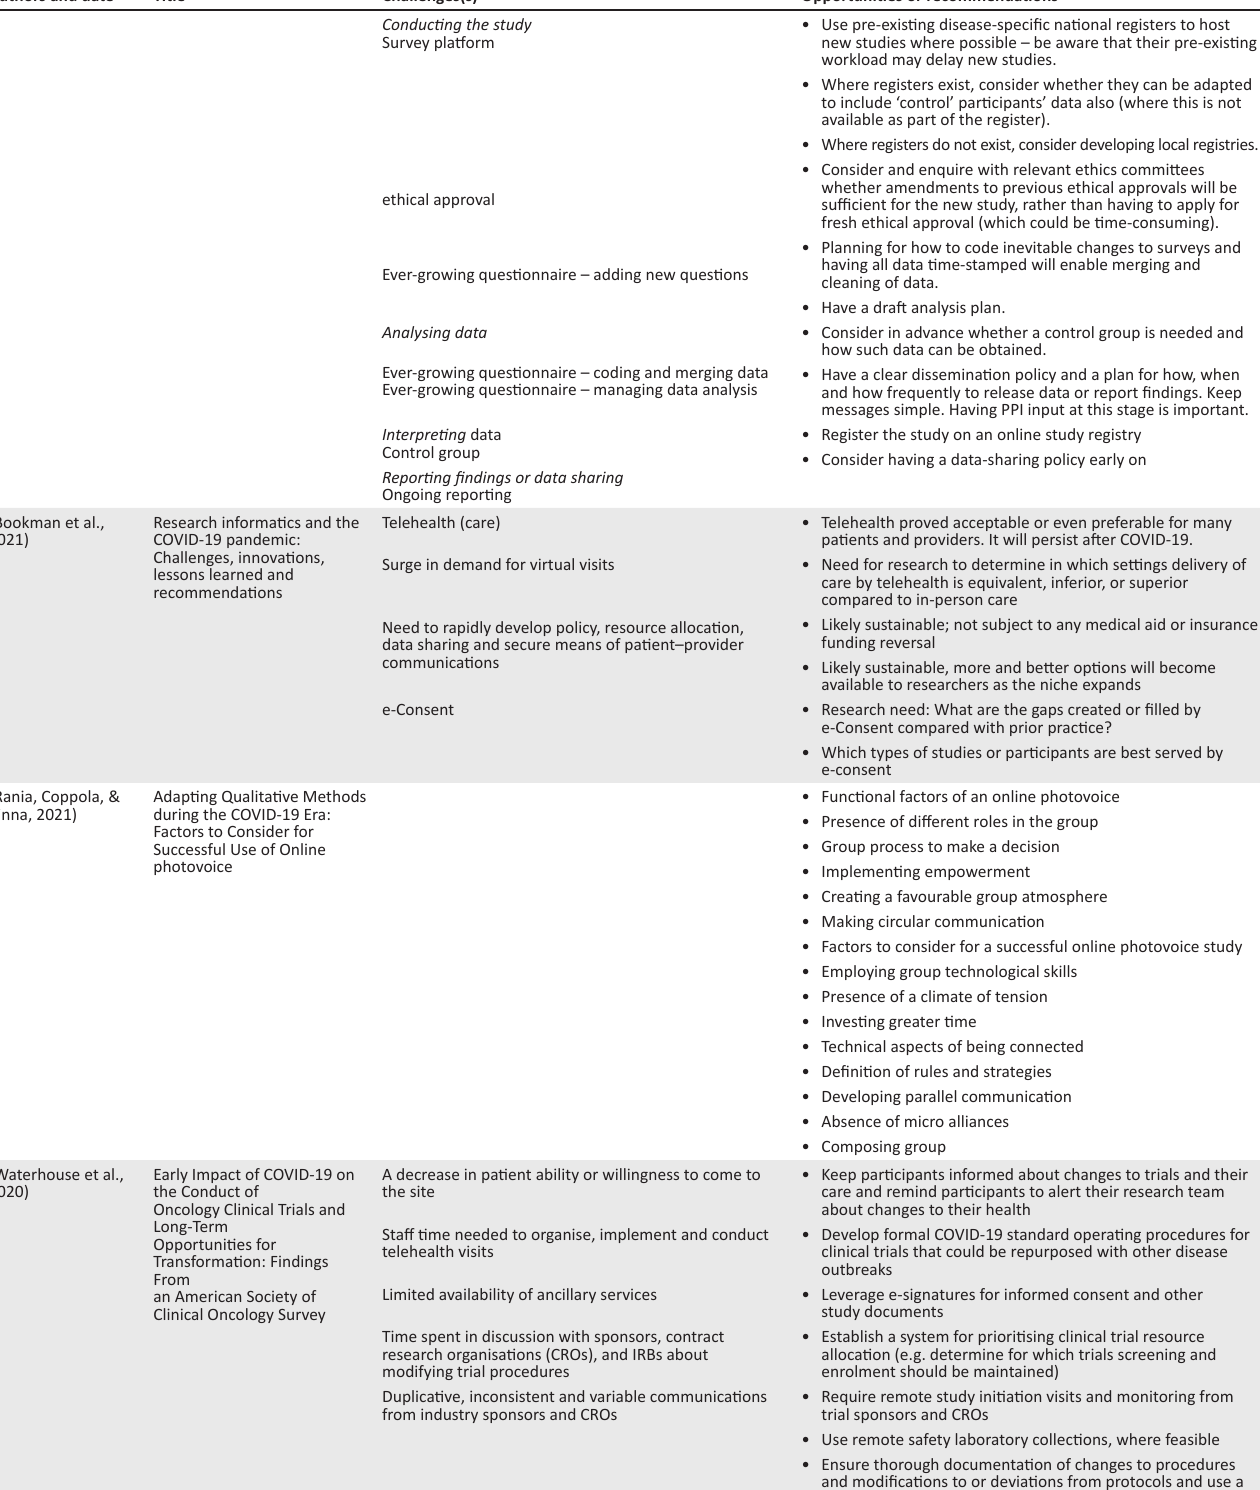
TABLE 1 (Continues...): Summary of studies included in the scoping review documenting clinical research challenges and opportunities during